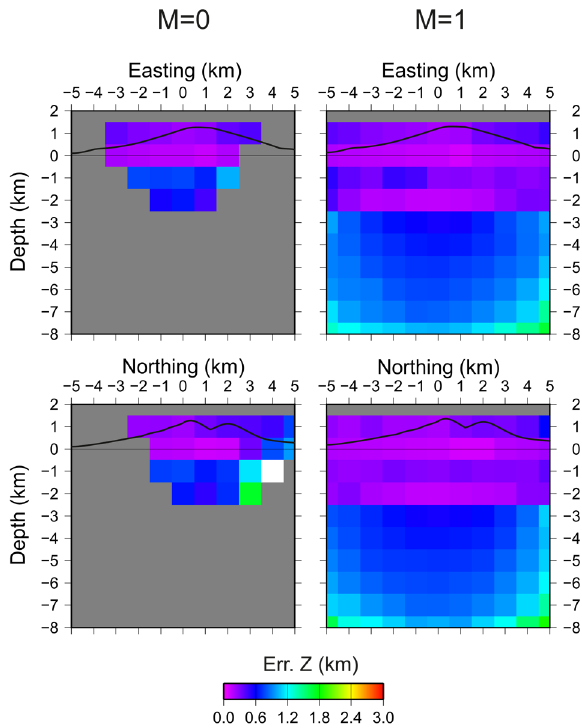
Figure 4. Results of the analysis of the location uncertainty of the seismic network for two earthquake magnitudes: M = 0 and M = 1. The color scale indicates the vertical error on the hypocenter